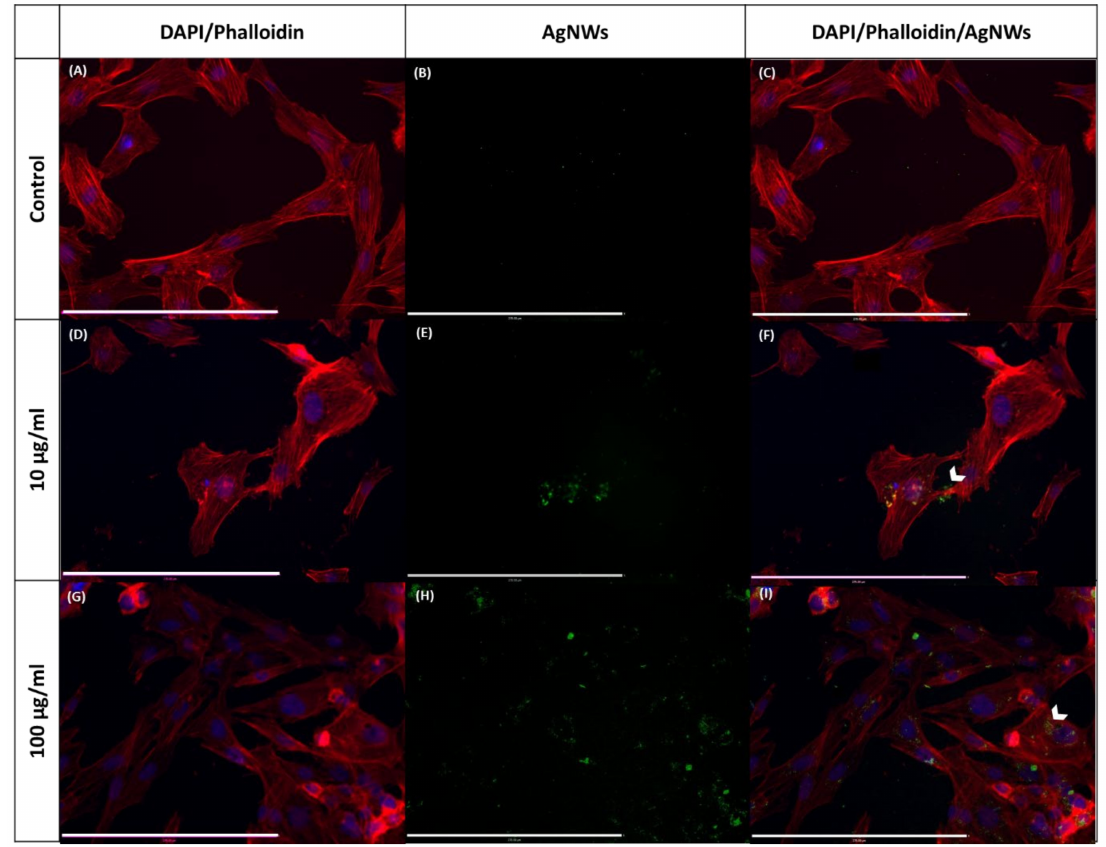
Figure 10. Phalloidin Dylight 550- and DAPI-stained osteoblast cells at 24 h of incubation with AgNWs (10 and 100 µ g / mL). ( A , D ) and ( G ): merged images of Phalloidin (staining F-actin) and DAPI (staining nuclei) of osteoblasts. ( B , E ) and ( H ): AgNWs excited at 495 nm and emitting at 519 nm. ( C , F ) and ( I ): merged images of Phalloidin / DAPI / AgNWs. Scale bar 270 µ